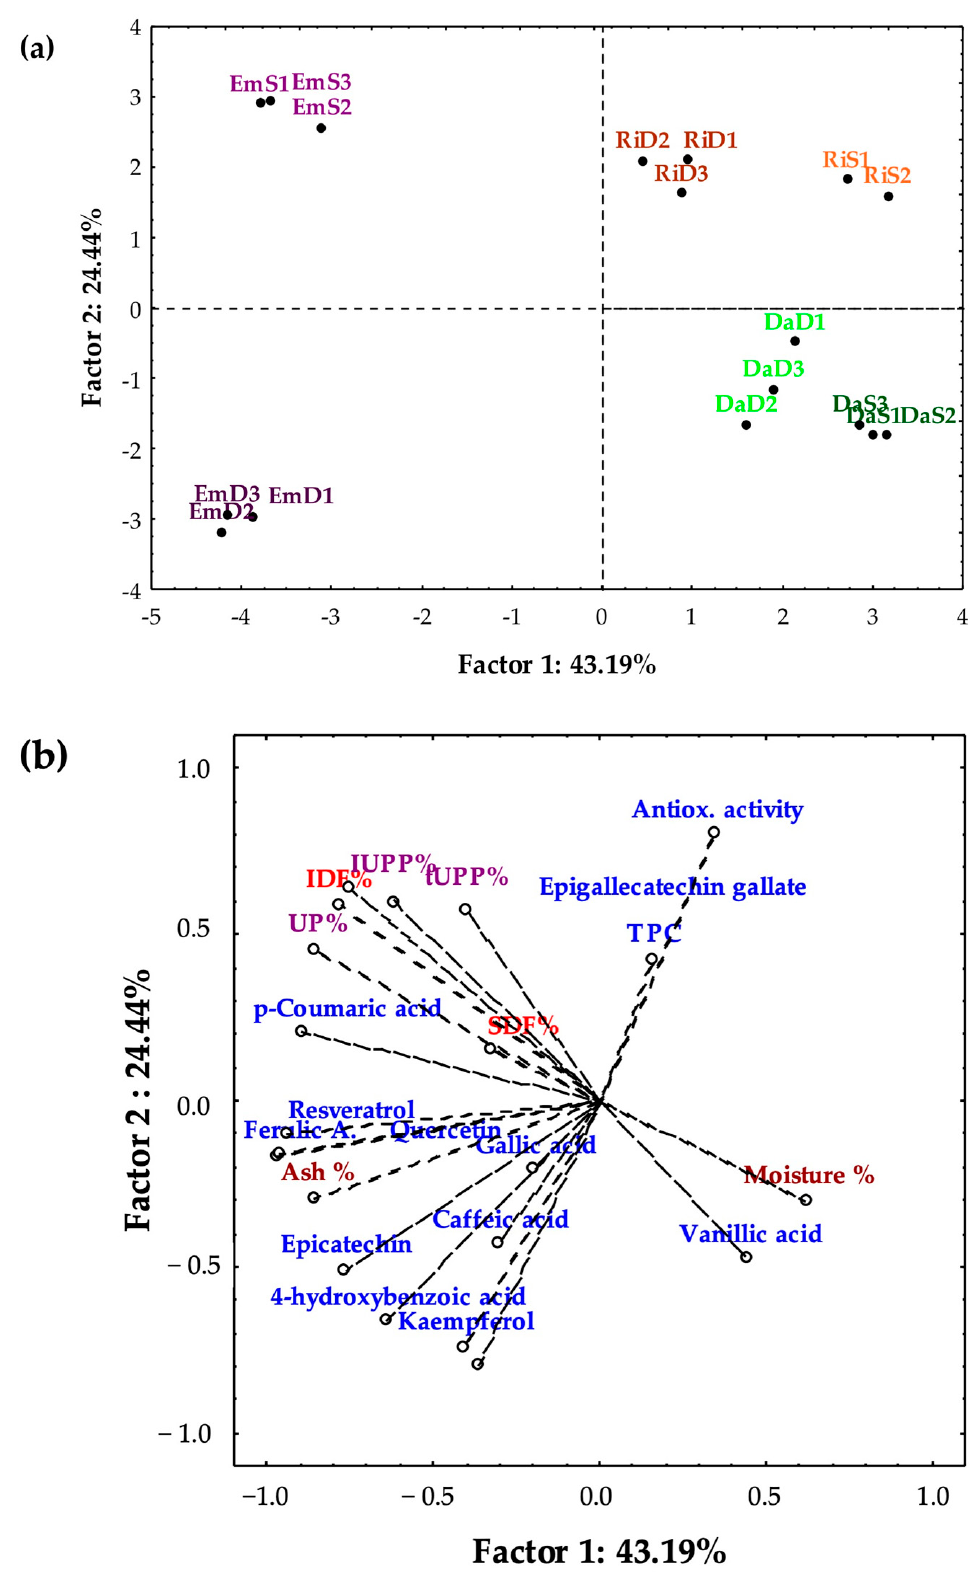
Figure 3. Projections of ( a ) BSG samples and ( b ) the related experimental data on the factorial plane. Phenolics are in blue font; Insoluble and Soluble Dietary Fibres are in red; tUPP%, lUPP%, and UP% are in purple; Moisture % and Ash % are in brown.